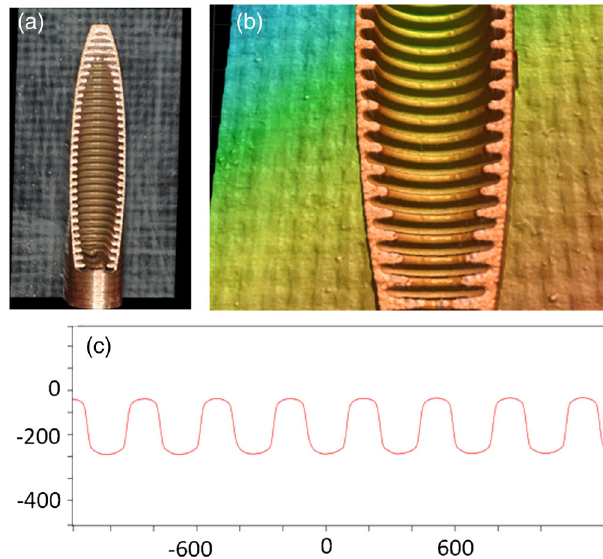
FIG. 9. The electron beam image at the energy collimator